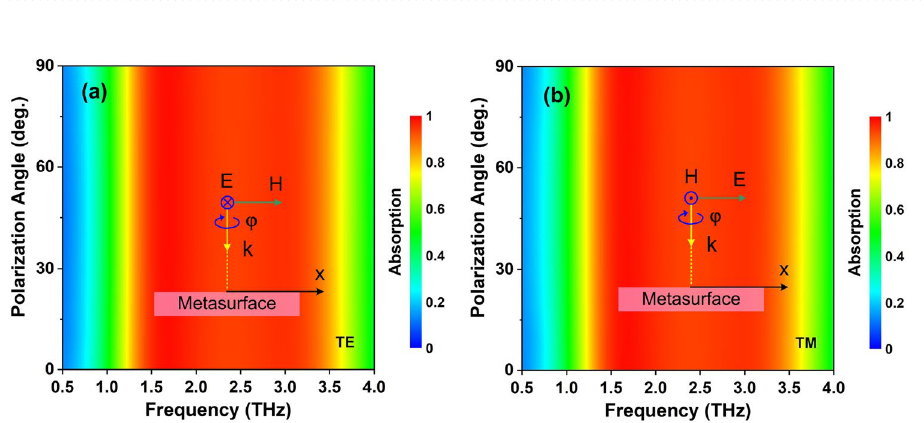
Figure 8. Dependence of absorption on polarization angle ( ϕ ) of the proposed RMS for ABS mode under ( a ) TE and ( b ) TM polarizations.